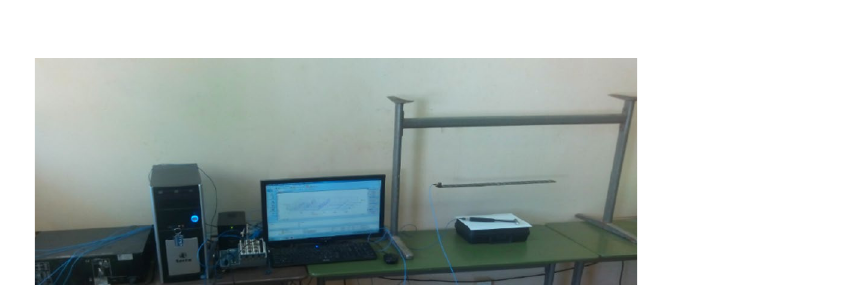
Table 1. Material properties.